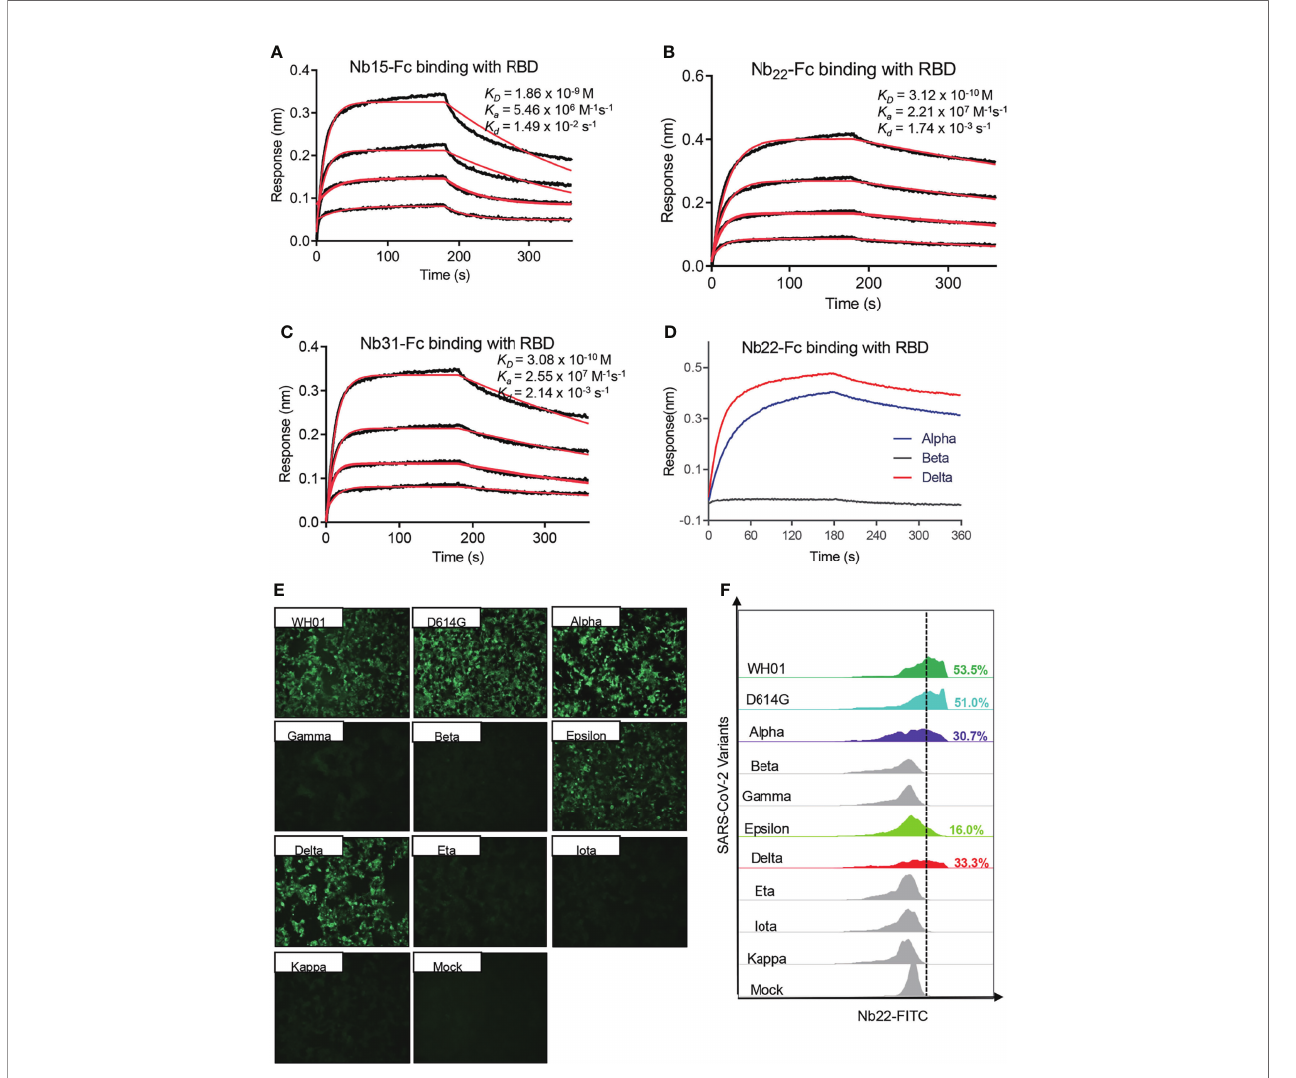
FIGURE 2 | Characterizing the binding of Nbs. Kinetic binding curve of Nb15-Fc (A) , Nb22-Fc (B) , and Nb31-Fc (C) at the concentrations 33.3, 11.1, 3.7, and 1.2 nM with RBD of Delta variant, respectively, detected by BLI. Binding curves are colored black, and fi t of the data to a 1:1 binding model is colored red. (D) Representative binding curve of various RBD as indicated to Nb22-Fc tested by BLI. Nb22-Fc binding with RBD from representative SARS-CoV-2 variants detected by immuno fl uorescence assay (E) and fl ow cytometric analysis (F) , respectively. Mock served as a cell control without plasmid transfection. Images were visualized under the ×10 objective. All experiments were repeated at least